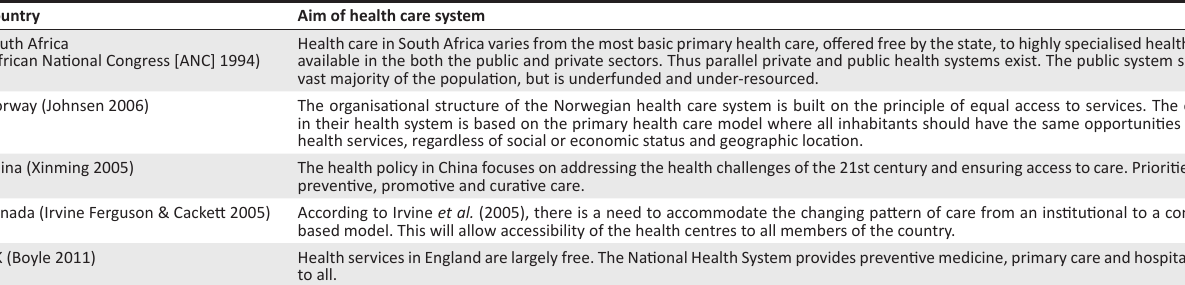
TABLE 4: Health care systems identified.